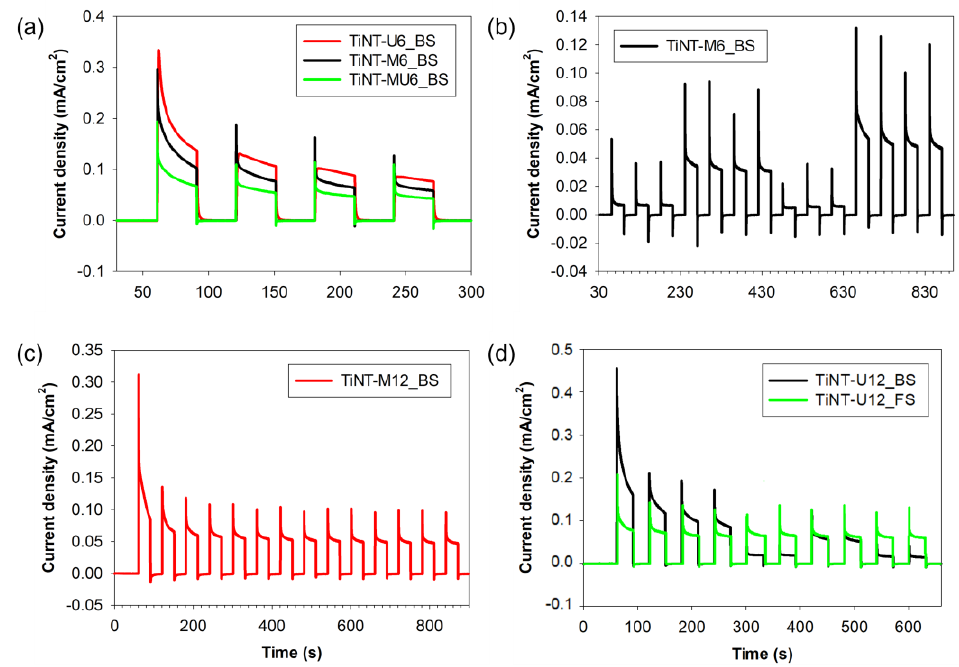
Figure 8. Chronoamperometric plot of ( a ) TiNT-M6 , TiNT-U6, and TiNT-MU6 composites showing their different photocurrent responses under irradiation; ( b ) TiNT-M6 under different irradiations (recorded by using from left to right: UVC blocking, UVB/C blocking, and AM1.5G filter) and without filter (full Xe lamp spectrum), respectively; ( c ) Chronoamperometric plot of ( c ) TiNT-M12 highlighting the stability of the signal after the first five on – off cycles [38]; and ( d ) photocurrent response of the front (bare TiNT) and backside (covered by g-C 3 N 4 ) of the TiNT-U12 composite electrode, highlighting the signal increment in the 1 – 4 cycles (black line) for longer times (300 – 400s and 540 – 660s intervals), where the lower photocurrents are due to the use of UVC and UVB/C blocking filters, respectively.